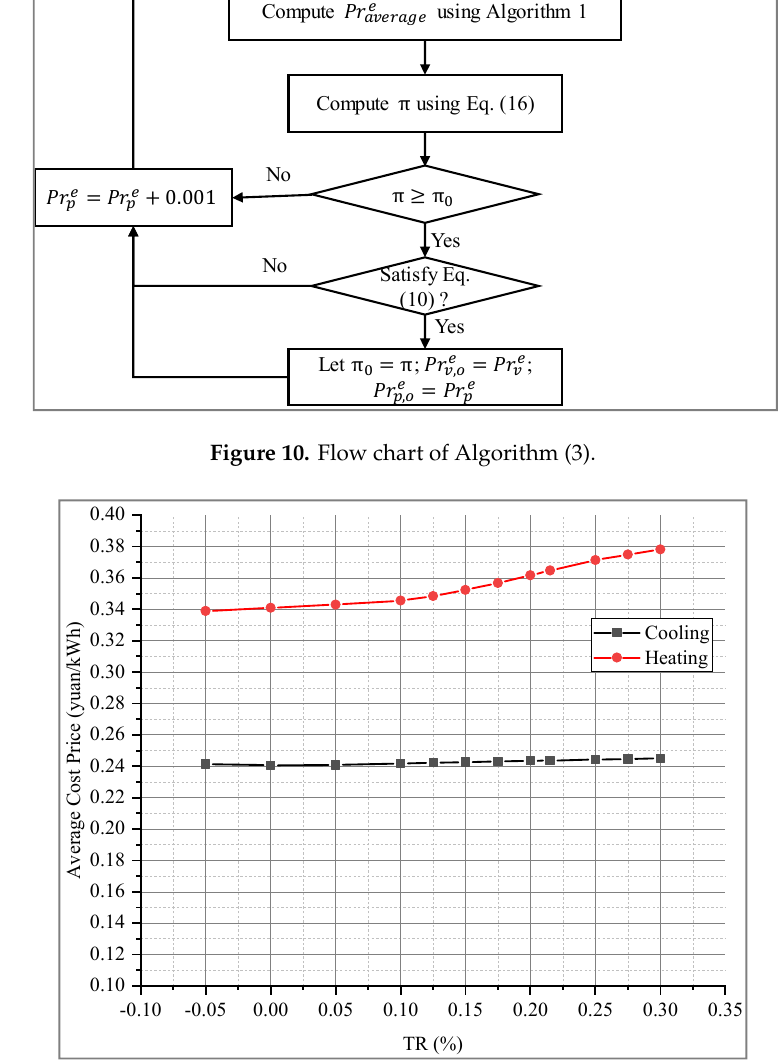
Figure 11. Cost price curves of heating and cooling.